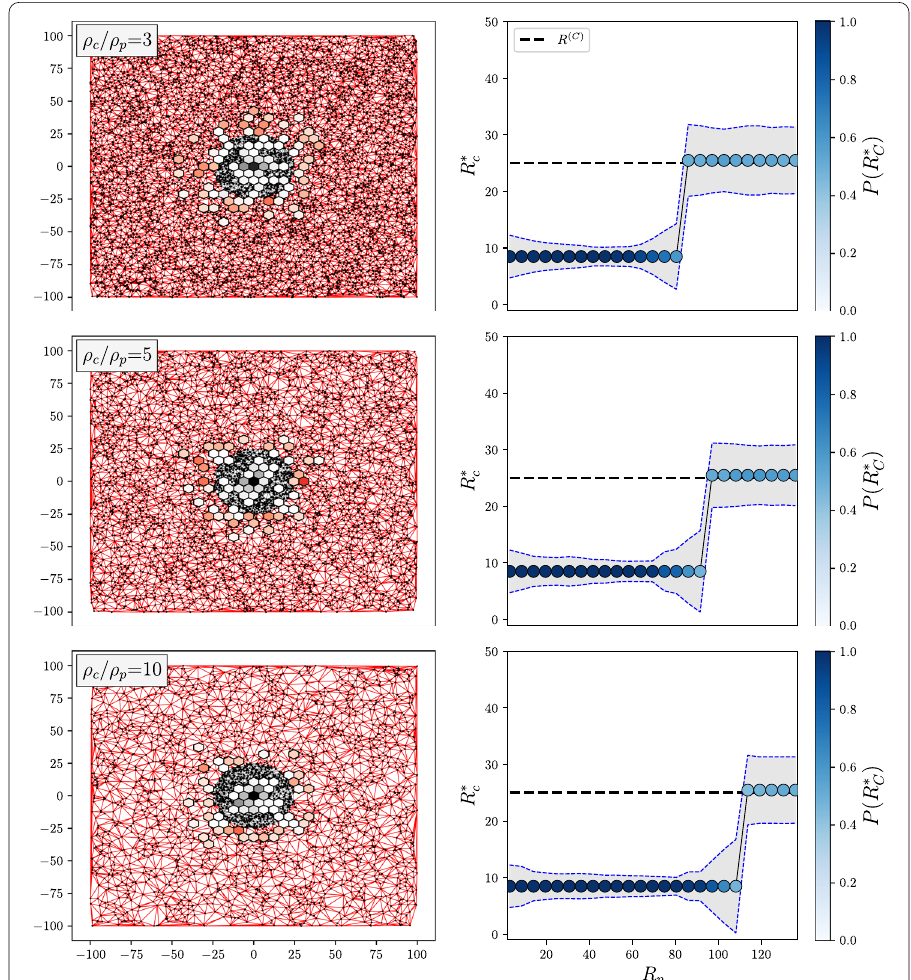
Fig. 7 Spatial behavior of congestions for the network model introduced in “Center‑periphery entanglement with non‑uniform nodes distribution” section. Left column shows the network configuration, where center and peripheral edges are painted in black and red, respectively. Here, hexagonal bins provide an information about the location of maximum betwenness nodes. Right column presents the dependence of the congestion radius on the patch one. Here, circles are located at the statistical mode over an ensemble of 100 realizations of different random distributions of nodes in a square of side equal to L = 100 , with R ( c ) = 5 , ρ c = N , ( N = 10000 ). Rows refer to different density ratio. The figure depicts a clear transition pattern as π( R ( C ) ) 2 that detected in Fig.